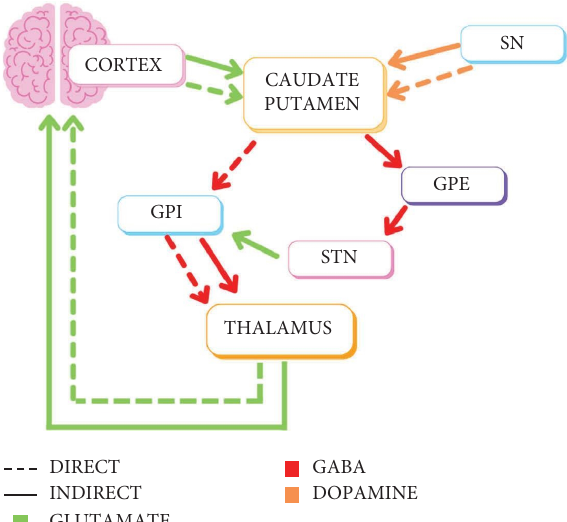
Figure 1: Direct and indirect pathways of the basal ganglia. Te direct pathway, represented by the dashed line, begins in the cortex, sending a stimulatory signal to the caudate and putamen. Te caudate and putamen then send inhibitory signals to the GPi which inhibit the thalamus, therefore inhibiting an inhibitor, leading to overall stimulation of movement. Te indirect pathway, represented by the solid line, also begins by the cortex stimulating the caudate and putamen. Te caudate and putamen then send an inhibitory signal to the GPe. Te GPe inhibits the subthalamic nucleus which stimulates the GPi. Terefore, the end result of the indirect pathway is stimulation of the inhibitory GPi, leading to inhibition of movement. Te substantia nigra acts on both pathways using dopamine, using D1 receptors to stimulate the direct pathway and D2 receptors to inhibit the indirect pathway. (SN, substantia nigra; GPE, globus pallidus externus; GPI, globus pallidus internus; STN, subthalamic nucleus).